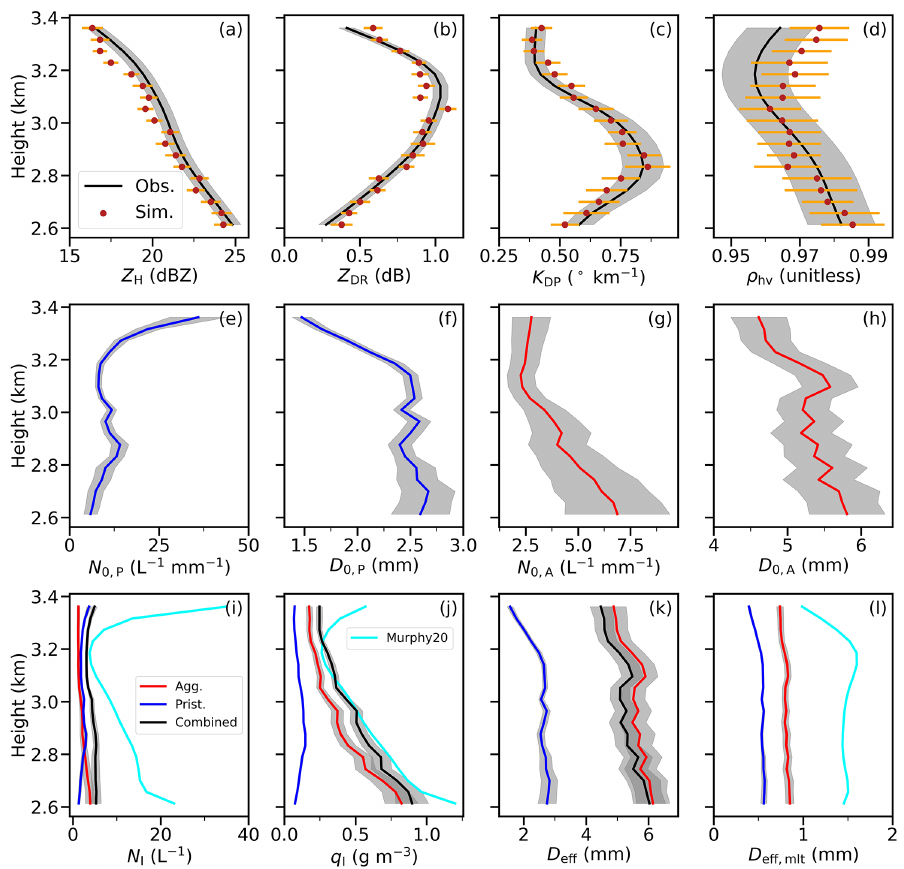
Figure 8. Retrieval performance for a radar ray at 08:37:39UTC. Observed and forward-simulated profiles of (a) Z H , (b) Z DR , (c) K DP , and (d) ρ hv . The shading in (a) – (d) represents the observational uncertainty. The red dots represent the mean of the ensemble simulations, and the error bars represent 1 standard deviation in forward simulations. Panels (e) – (j) represent the retrieved mean normalized pristine-ice number concentration, pristine-ice normalization diameter, normalized aggregate number concentration, aggregate normalization diameter, the total number concentrations, and the total ice water content, respectively. Panels (k) and (l) represent the individual and combined effective mean diameters using the maximum particle dimension and the equivalent melted particle size as the size descriptor, respectively. The shading in (e) – (l) represents 1-standard-deviation uncertainty in retrieval. For comparisons, retrievals from Murphy20 are co-plotted in (i) , (j) , and (l)